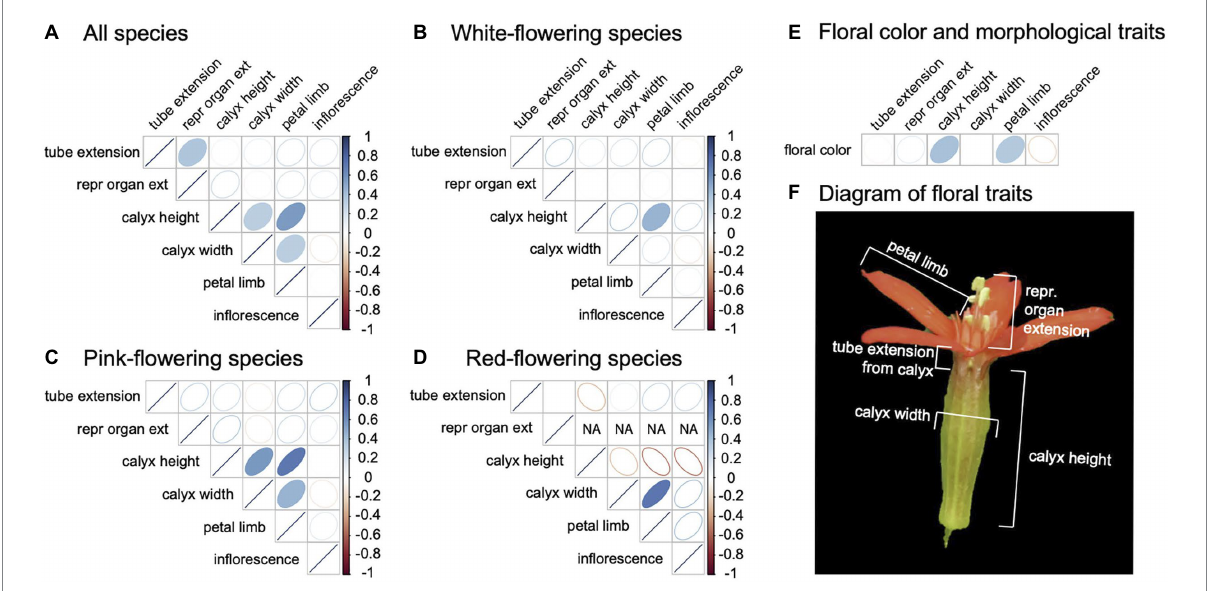
FIGURE 2 Floral morphological trait correlations in the total species dataset (A) , and within each floral color group [white (B) , pink (C) , red (D) ]. (E) Floral color is correlated with all traits in the total species dataset. Spearman rank correlations are depicted as ellipses, with the strength of Spearman’s rho (r) indicated by color and the direction of the ellipse indicating a positive or negative value. Statistically significant correlations ( p ≤ 0.05) are shown as ellipses with filled color. Cells with “NA” indicate that all phenotypic values were uniform for the trait, thus a correlation could not be calculated. (F) Traits included in this analysis, apart from inflorescence (see methods), are depicted on an S. regia flower. Samples sizes for all species ( n = 47), white-flowering species ( n = 20), pink-flowering species ( n = 18), red-flowering species ( n =